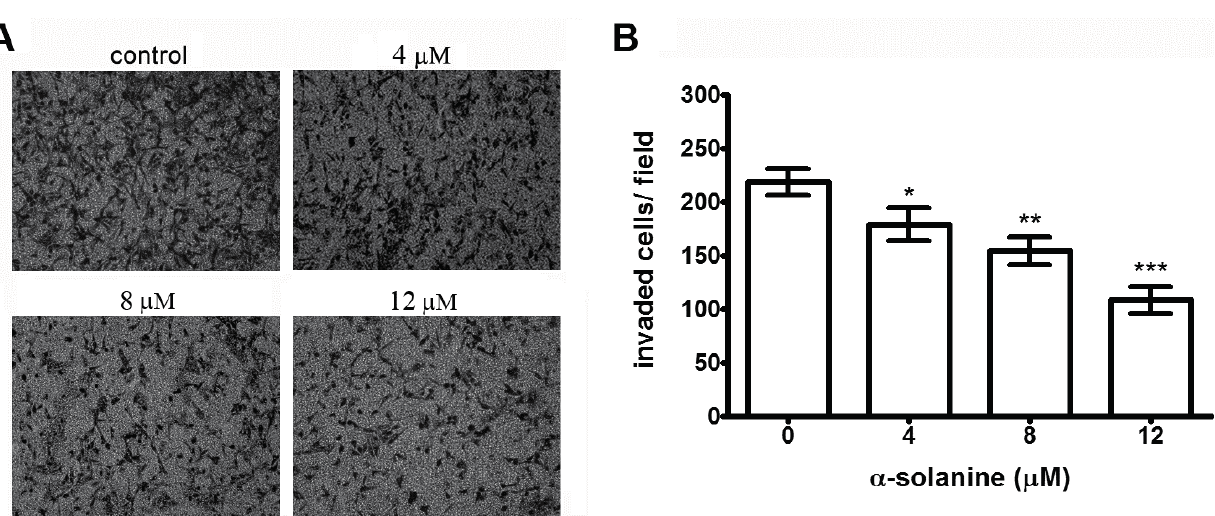
Figure 3. Effect of α -solanine on invasion of PC-3 cell. ( A ) Cells were treated with various concentrations of α -solanine for 24 h and cell invasion assay was performed. The invaded cells were photographed (200× magnification). ( B ) The invaded PC-3 cells were counted in five random fields in each treatment, and data were calculated from three independent experiments. Data are presented as mean ± S.D. of three independent